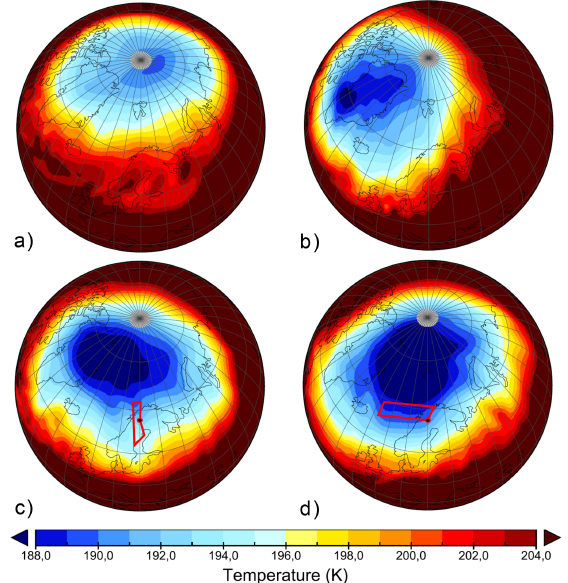
Figure 3. ERA-Interim data of temperature at the 30hPa level dur- ing the ESSenCe campaign on the following UTC times in Decem- ber 2011: (a) 4 December 00:00; (b) 8 December 18:00; (c) 11 De- cember 12:00, corresponding to the first flight; and (d) 6 December 18:00, close to the second flight. Flight tracks are denoted by red lines. The polar vortex established during December